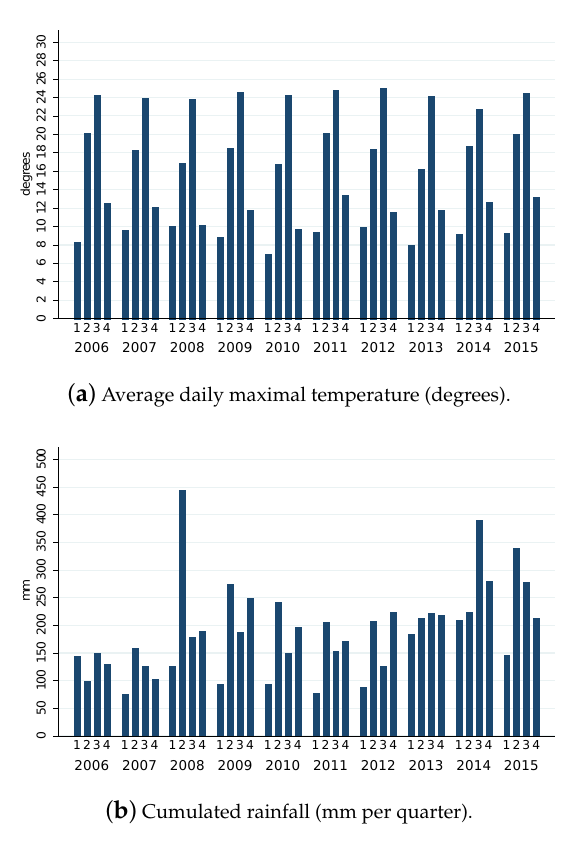
Figure A1. Average of daily maximal temperature (degrees) and cumulated rainfall (mm per quarter) at the Roc de Sant Pere meteorological station. 1, 2, 3 or 4 for January–March, April–June, July–September and October–December, respectively.